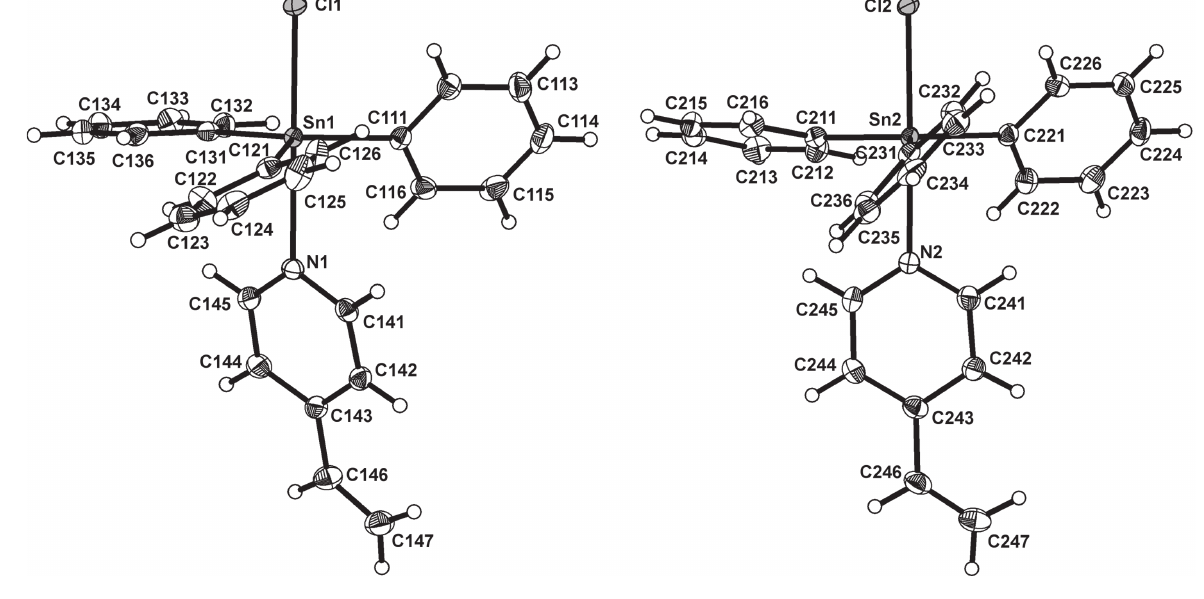
Table 1: Data collection and